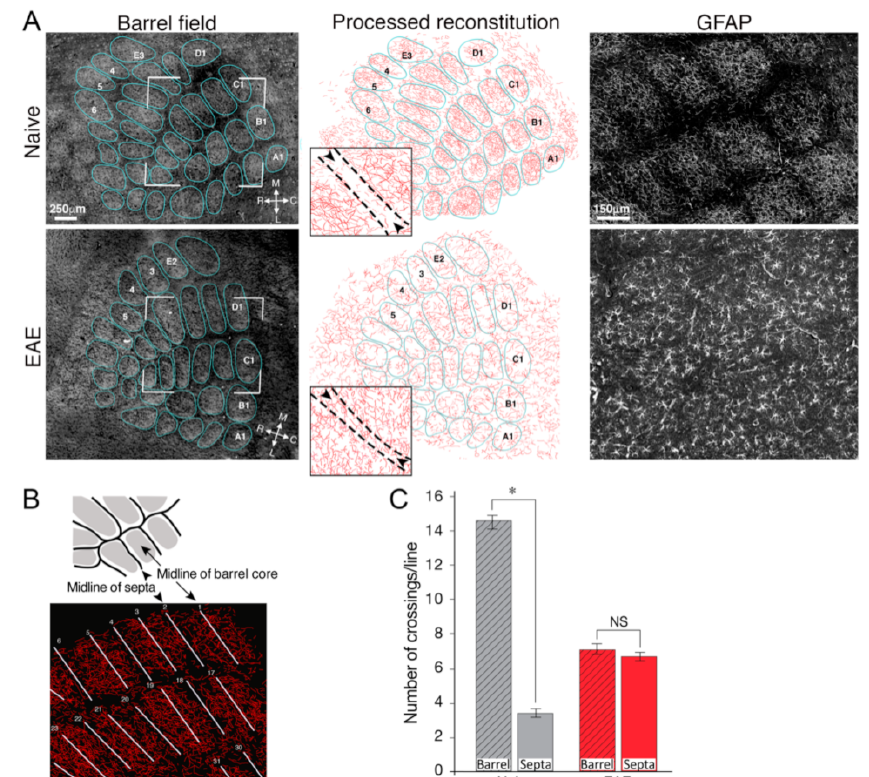
Figure 4. Loss of astrocytic confinement to the neuronal boundaries under inflammation. Representative images from layer IV of naïve and EAE mice, 21 days after EAE induction. ( A ) Left column: dark field illumination of the barrel field area. Middle column: reconstruction of the astrocyte processes performed by manually drawing their branches from GFAP-stained astrocytes. Clear gaps in astrocyte distribution at the barrel boundaries are visible in naïve, but not in EAE mice. Right column: images of astrocytes at high magnification stained with GFAP. ( B ) Schematic drawing of the barrel field, and an example of lines drawn at the septa centers or the barrel cores. ( C ) Quantitative analysis of astrocyte processes crossing the line drawing at the septal and barrel cores. * p < 0.001; NS, not significant. Adapted with permission